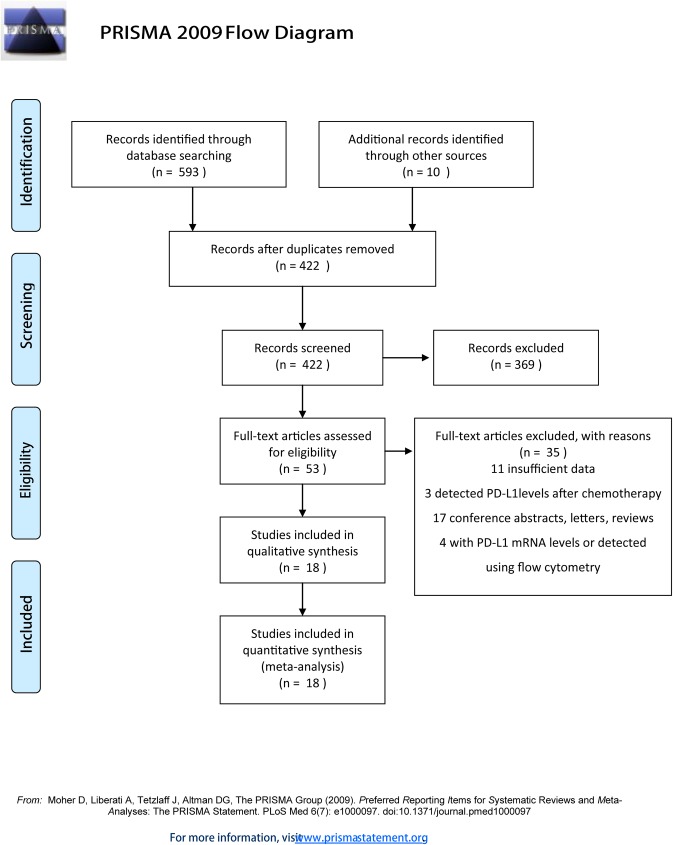
Flow diagram of the literature search and study selection for the meta-analysis.The flow diagram shows eligible publications at each stage of the analysis process. The database search was conducted in December 2016.